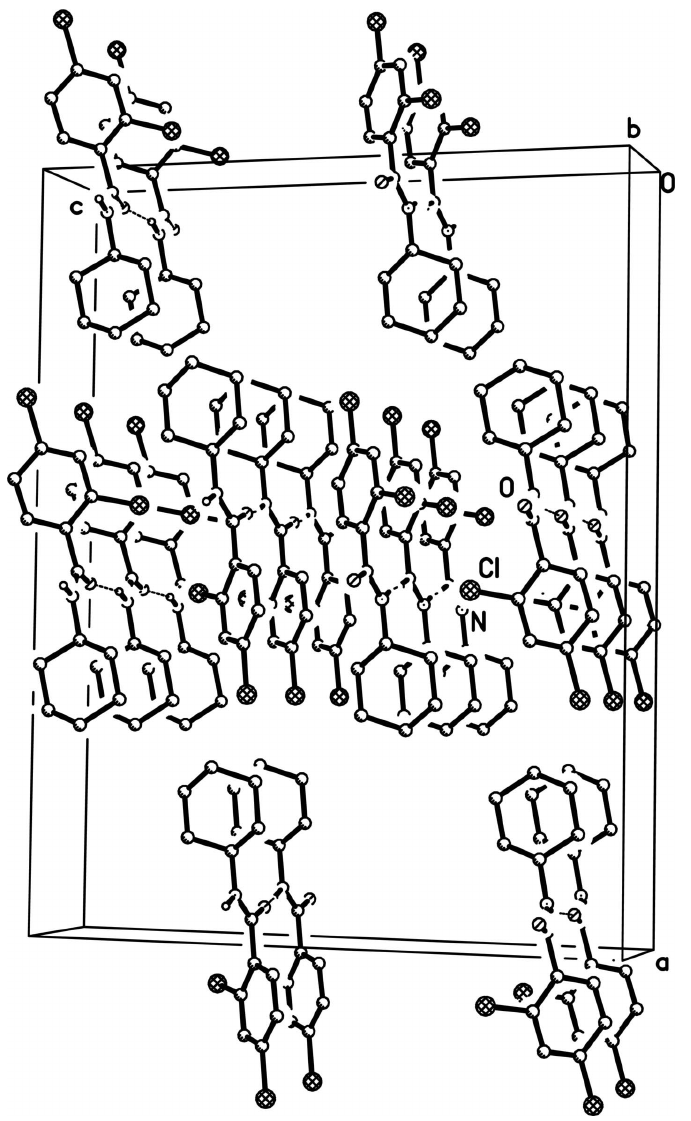
A packing diagram for (I). Hydrogen bonds are shown as dashed lines. H-atoms not involved in hydrogen bonding are omitted for